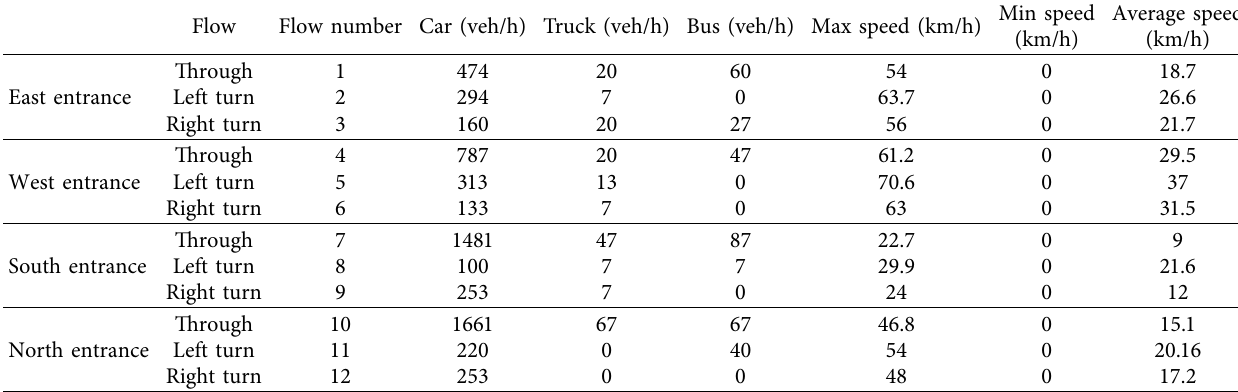
Table 3: Collected data during the peak hour of 5:00 p.m. to 6:00 p.m. on 21 October 2020.